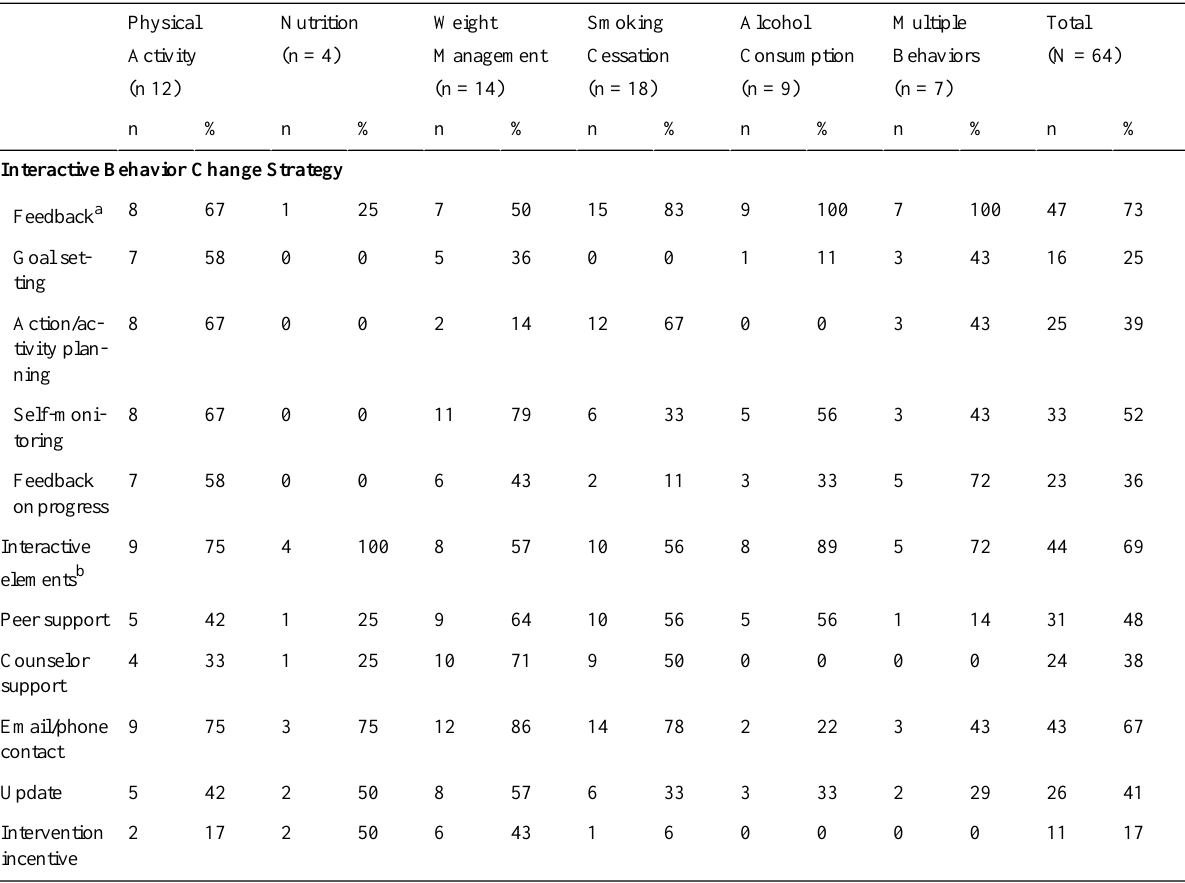
Table 2. Potential exposure-improving methods and strategies applied in the Internet interventions for the various health-related behaviors (see Multimedia Appendix 1 for